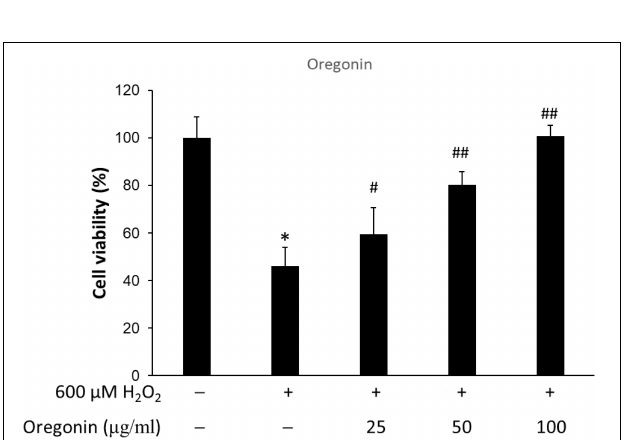
FIGURE 4 | Anti-apoptotic effects of 60% ethanol extract from Alnus sibirica Fisch. ex Turcz (ASFT) on H 2 O 2 -induced oxidative damage in hair follicle dermal papilla cells. The cells (1 × 10 5 cells) were pre-incubated with 60% ethanol extract from ASFT in various dosages or in control medium for 10 min at 37 ◦ C in a CO 2 incubator. Then, the cells were treated with H 2 O 2 (final concentration, 600 µ M) and further incubated for 12 h. The harvested cells were solubilized with protease inhibitors (Sigma-Aldrich, MO, United States) containing radioimmunoprecipitation assay buffer (Elpis Biotech, Seoul, South Korea) and analyzed by western blotting by using PARP-1, Bax, Bcl-2, caspase-3, and β -actin-specific antibody. +, present; –,